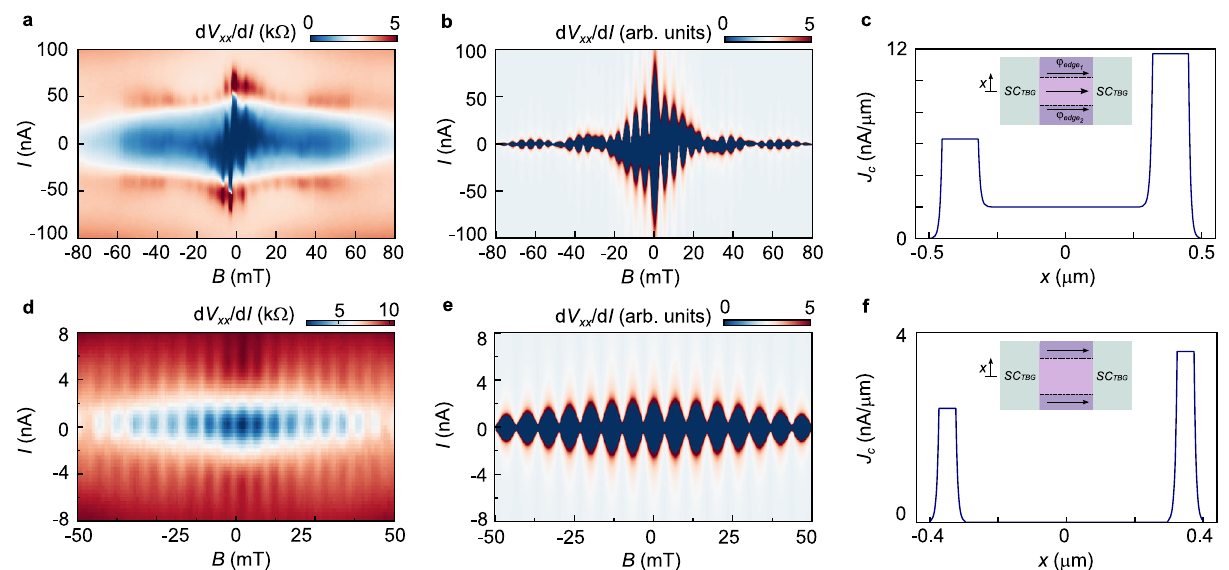
Fig.2|FraunhoferpatternsemergingfromedgestatesupercurrentofdeviceA andB.a FraunhoferpatternattheSC/CI ’ /SCpositionofsampleAuptohigherout- of-plane magnetic fi eld B . A revival of the oscillations is observed after 30mT. b Calculated I c (B) behavior based on the current density distribution shown in c . A combination of edge and bulk supercurrent with non-symmetric edges having different phases φ edge,n , where n =1, 2 for the top and bottom edge respectively, such that φ edge1 (I >0 ) = − π /4, φ edge1 (I <0 ) = π /4 and φ edge2 = − φ edge1 give rise to a qualitatively similar pattern as measured in the experiment. c Current density distribution combining edge and bulk supercurrent. The inset shows a cartoon